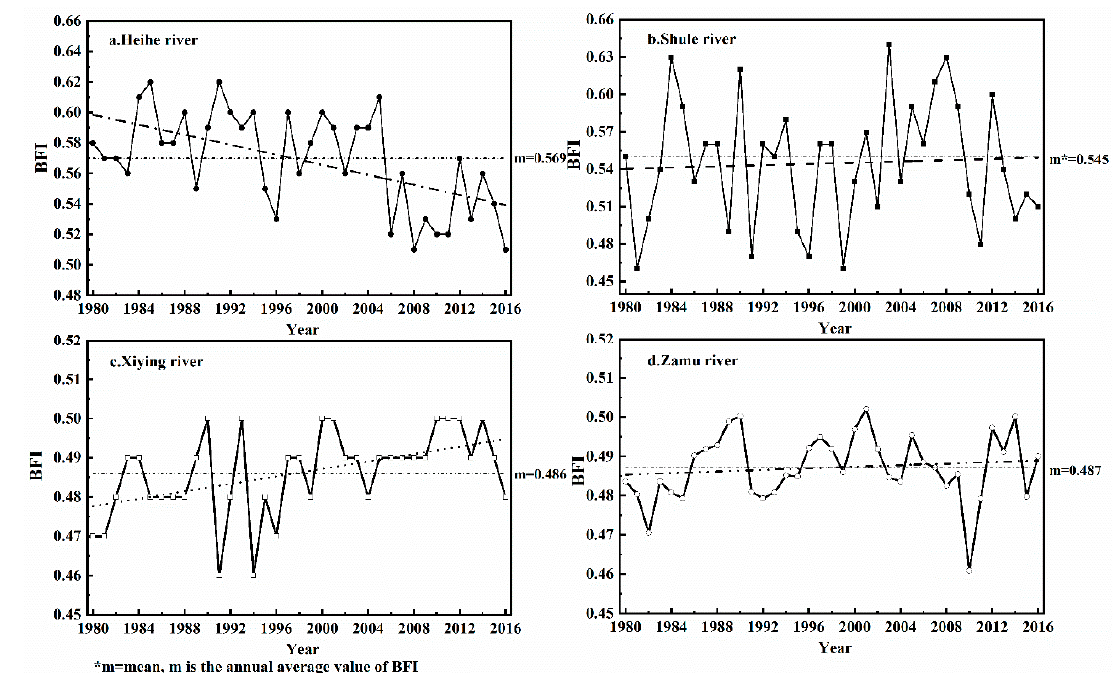
Figure 5. The trend of the inter-annual BFI in the Hexi inland rivers basin: ( a ) the Heihe River; ( b ) the Shule River; ( c ) the Xiying River; ( d ) the Zamu River.